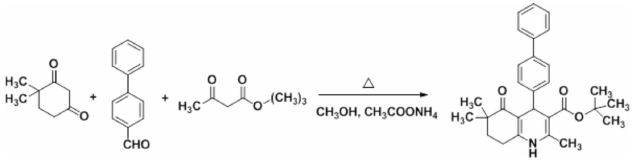
Figure 7 Schematic synthetic route for the title